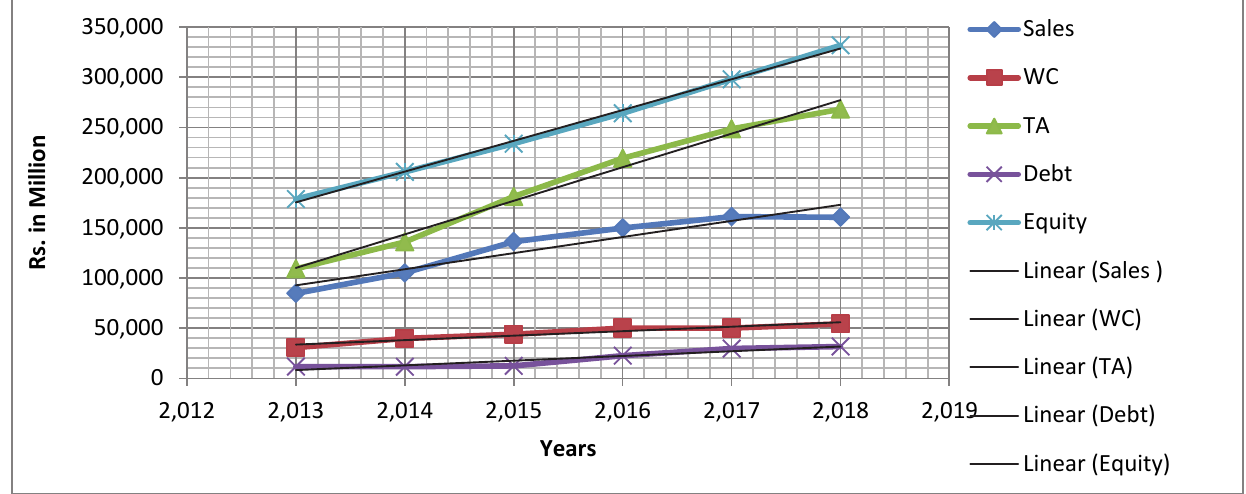
Fig. 1. Trend of average absolute amounts of size determinants (sales, WC, and TA), LTD & Equity of Indian pharmaceutical